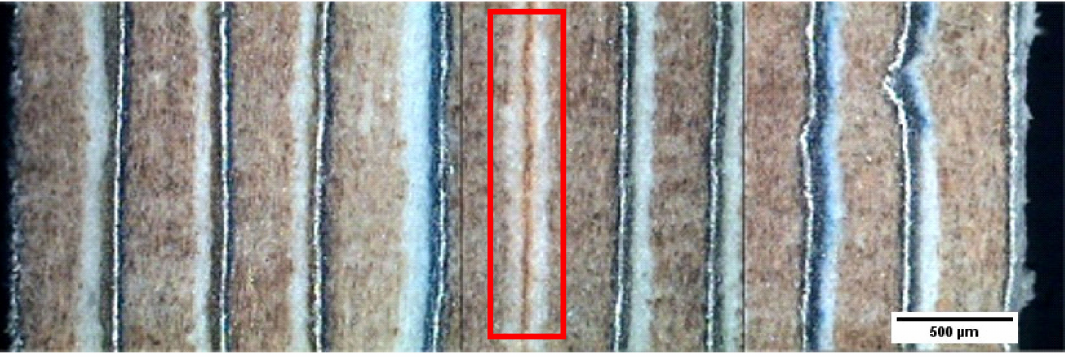
Figure 16. Micrograph of 10 sheets (G1). The “neutral or central” layer is marked with a rectangle. The microstructural aspect of the sample of G1 series of 10 sheets (after the compression) is represented in Figure 17. In this figure, di ff erent random zones are shown, and a good adhesion between sheets can be